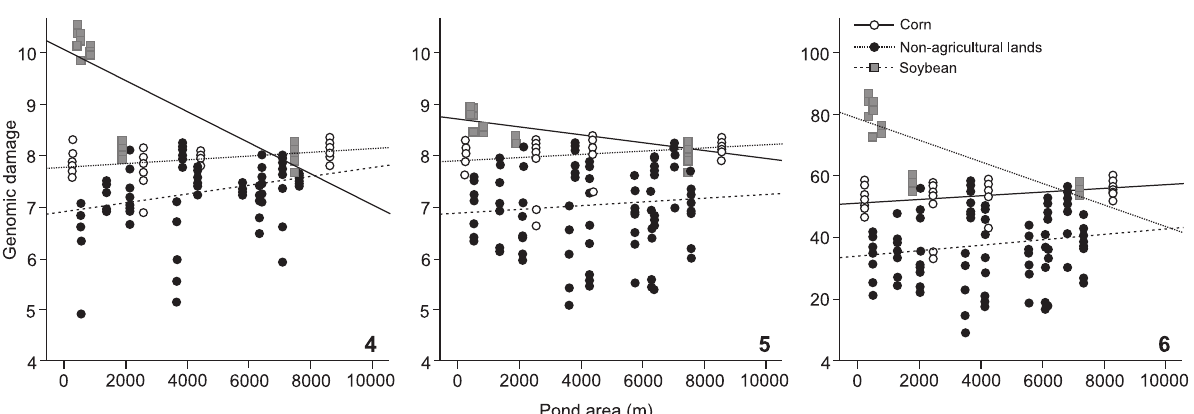
Figures 4–6. Relationship between comet assay parameters and the pond area according to soybean (gray squares), corn (white circles) and non-agricultural lands (black circles); 4) TL with pond area; 5)% DNA; 6) OTM with pond area. (TL) Tail Length, (% DNA) percentage of DNA in Tail, (OTM) Olive tail